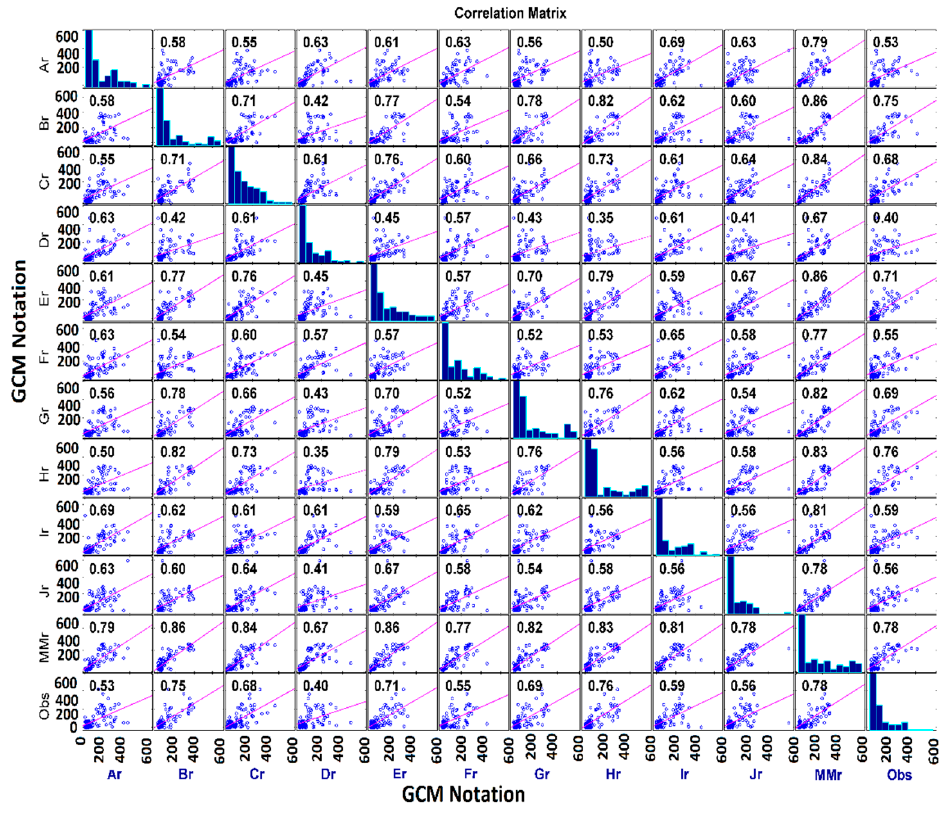
Figure 19. Correlation matrix of downscaled precipitation for different GCMs with the Re-Obs model for Uttarkashi. Markings are the same as the ones given in Figure 17.